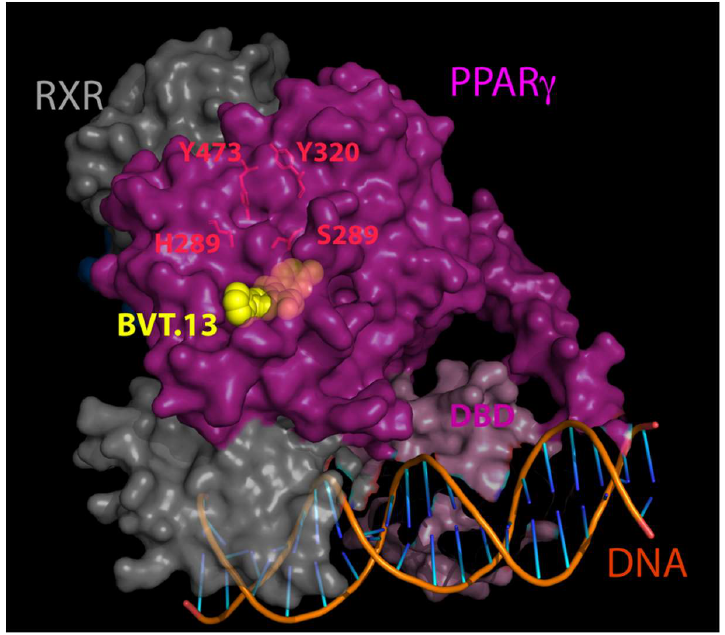
Figure 2. X-ray crystal structure of the complex of PPARγ (magenta) and retinoid X receptors (RXR) (grey) at 3.2 Å resolution. The BVT.13 agonist ligand is displayed as yellow balls. The amino acids residues, which form a ligand binding pocket, are shown in red . DNA-binding domain (DBD, light magenta) and DNA fragment are shown. The structure is derived from Protein Data Bank (PDB: 3DZU) [12] and visualized using PyMol software (v. 2.0.7).